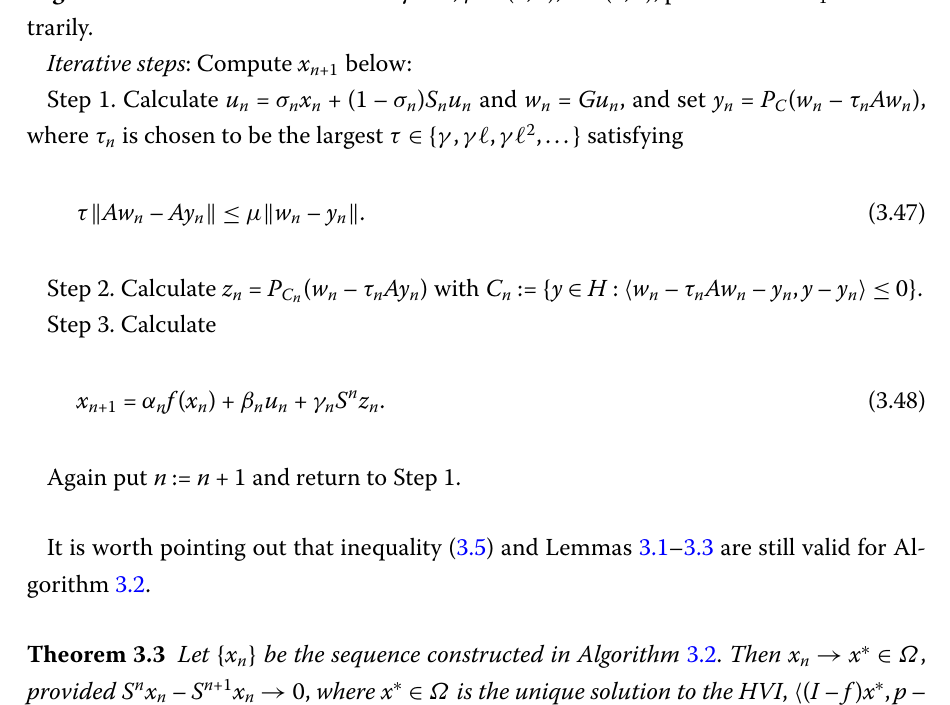
Algorithm 3.2 Initialization : Given γ > 0, μ ∈ (0,1), (cid:4) ∈ (0,1), pick an initial x 1 ∈ C